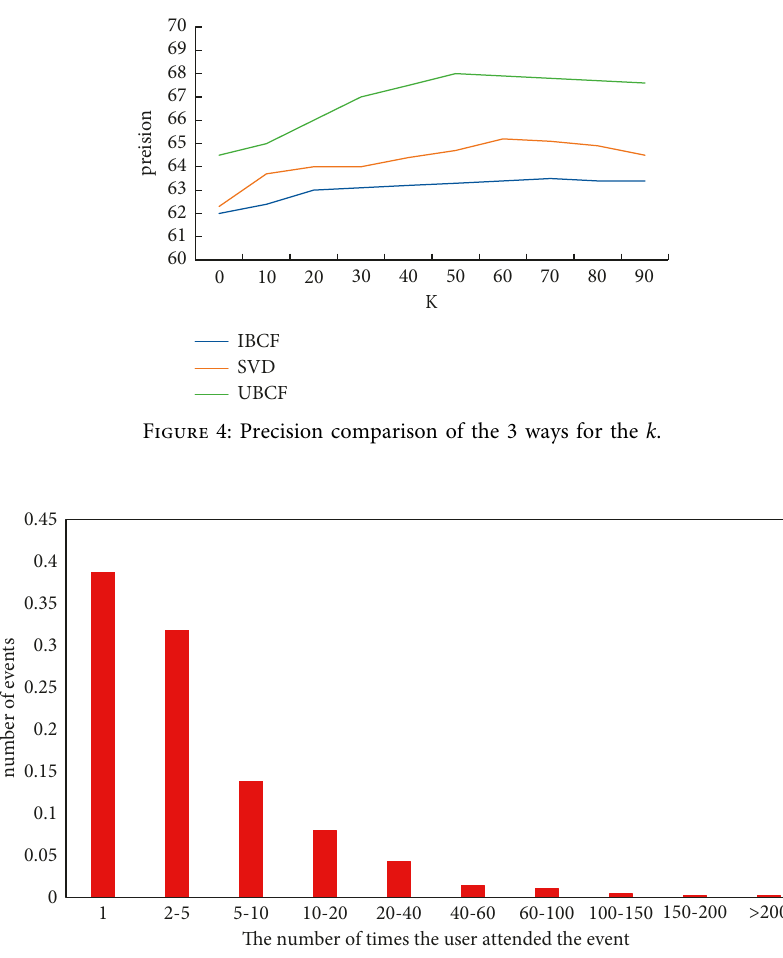
Figure 5: User similarity calculation